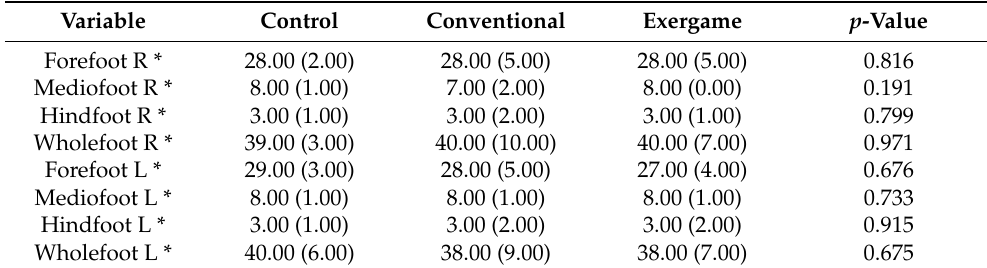
Table 1. Intergroup comparisons of the initial plantar tactile sensitivity (T0) of the older women participating in the study. Jequi é , Bahia,